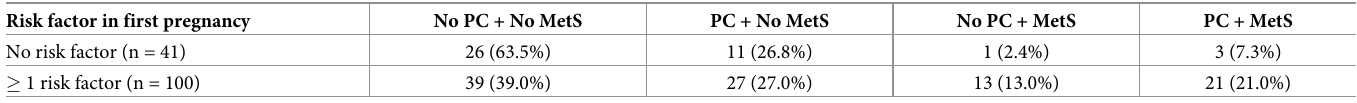
Results are number (%); PC, pregnancy complication; MetS, metabolic